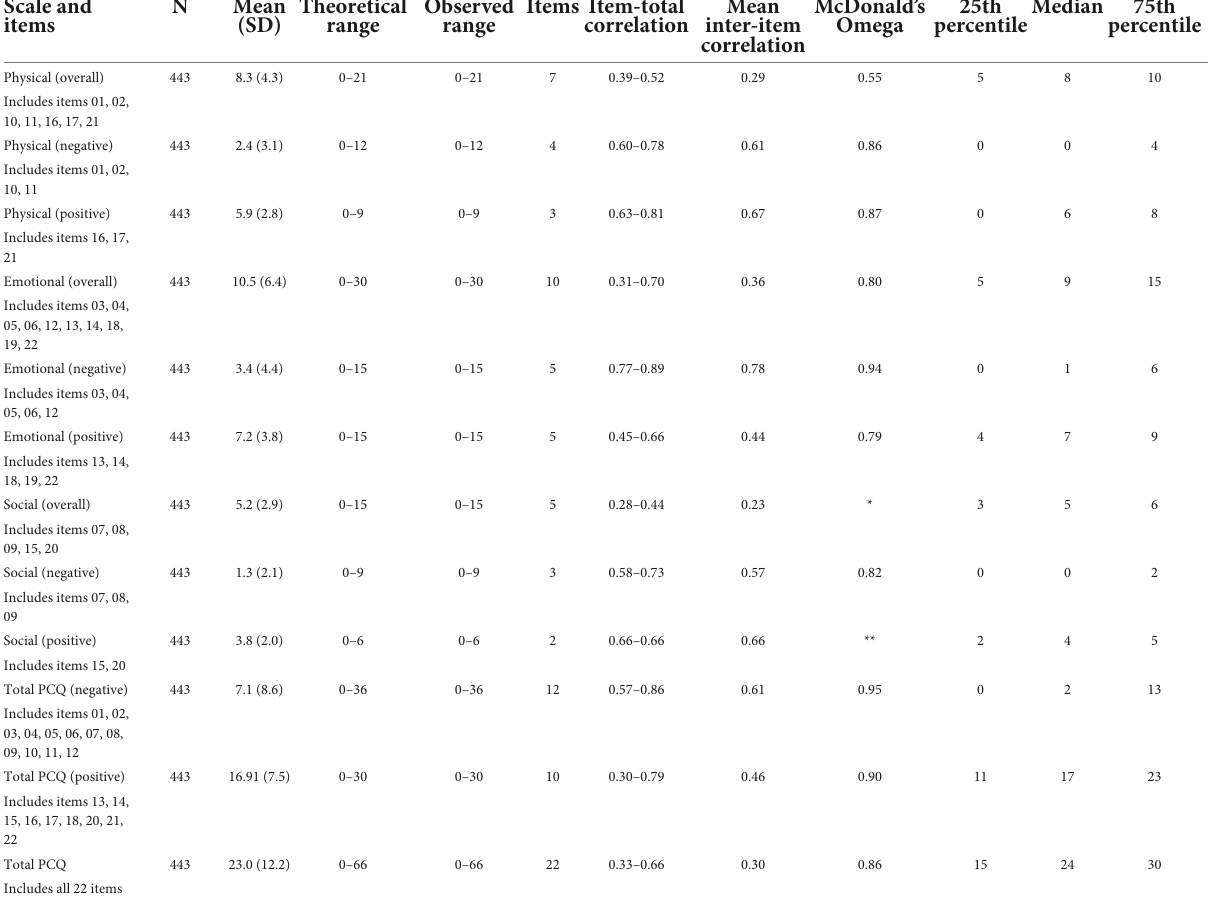
TABLE 2 Internal consistency: German version of the Psychological Consequences of Screening Questionnaire (PCQ). Scale and items